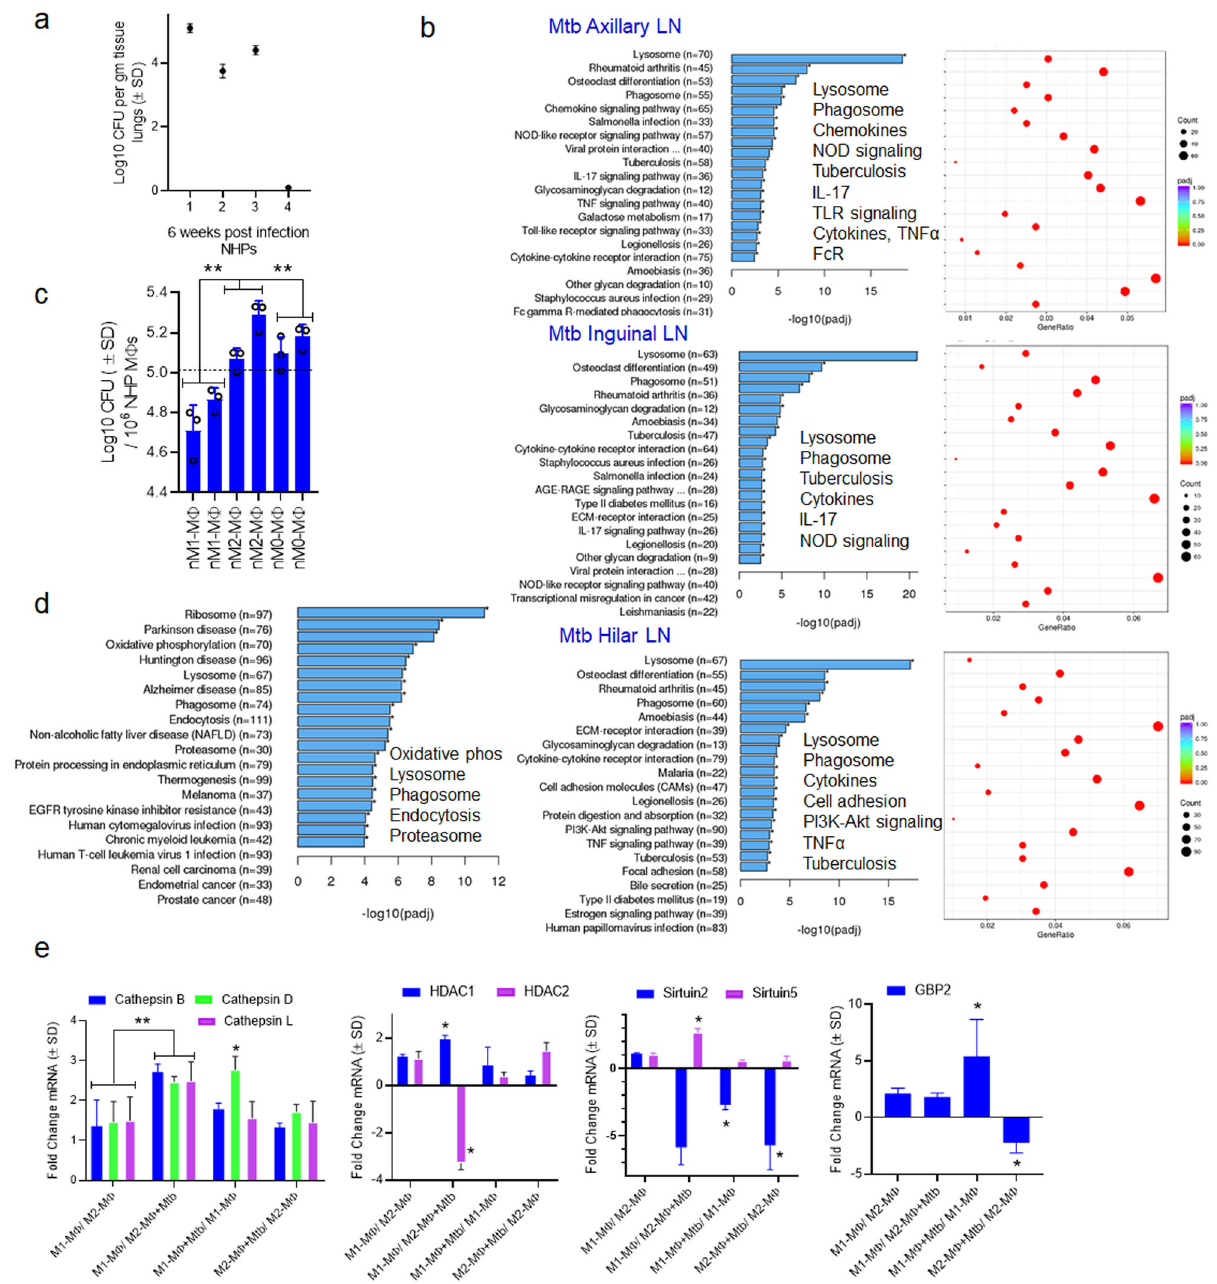
Fig. 7 Inreg clusters expressed by Mtb-infected human M1- and M2-M Ф s are found in the lymph nodes and macrophage transcriptome of Mtb-infected neonatal rhesus macaques. a Six-week-old rhesus macaques were aerosol-infected with Mtb Erdman strain (25 CFU per animal; n = 4) followed by sacri fi ce at 6 weeks and CFU counts of lungs. b lymph nodes ( n = 2) collected at necropsy from macaques that had comparable Mtb counts in lungs (panel a) were analyzed using RNAseq. Kyoto Encyclopedia of Genes and Genomes pro fi les of one NHP illustrate the differential gene expression for Inreg clusters ; Clusterpro fi ler pathway analysis of Inregs is illustrated in Supplementary Fig. 12. c M1-, M2-, and M0-M Φ s were prepared from the bone marrow of naïve macaques (pre fi x n) and infected with Mtb followed by CFU counts on day 4 (** p < 0.01 one-way ANOVA with Tukey ’ s post-hoc test; 2 experiments shown). d Kyoto Encyclopedia of Genes and Genomes pro fi les of Mtb-infected M1-M Φ s vs. Mtb-infected M2-M Φ s show enrichment of genes regulating antigen processing 18 h post-infection. e Naïve or Mtb-infected M1-, and M2-M Φ s were subjected to QPCR at 18 h post-infection using primers for mRNA of indicated genes which were differentially expressed in their human counterparts (* p < 0.01, t test). All ex vivo Mtb CFU experiments used MOI of